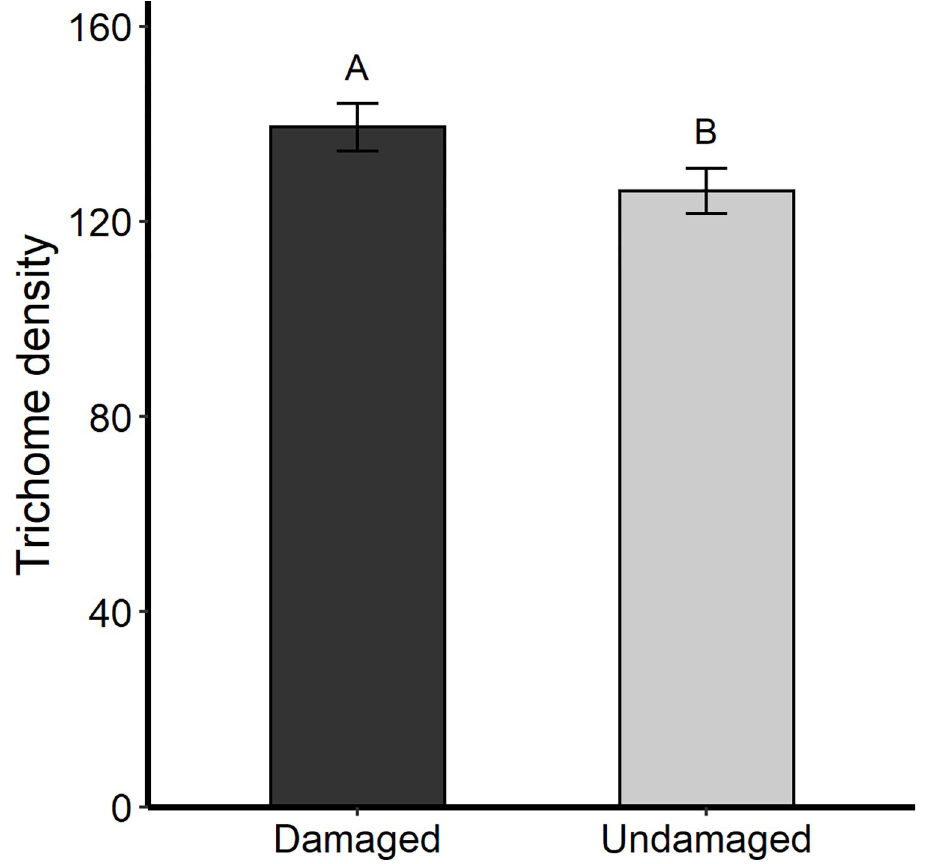
Fig 1. Adaxial leaf trichomes for offspring of herbivore-damaged and undamaged S . carolinense plants. Different letters indicate significant differences between maternal herbivory treatments determined by linear mixed-effects ANOVA ( P < 0.05). Error bars correspond to standard